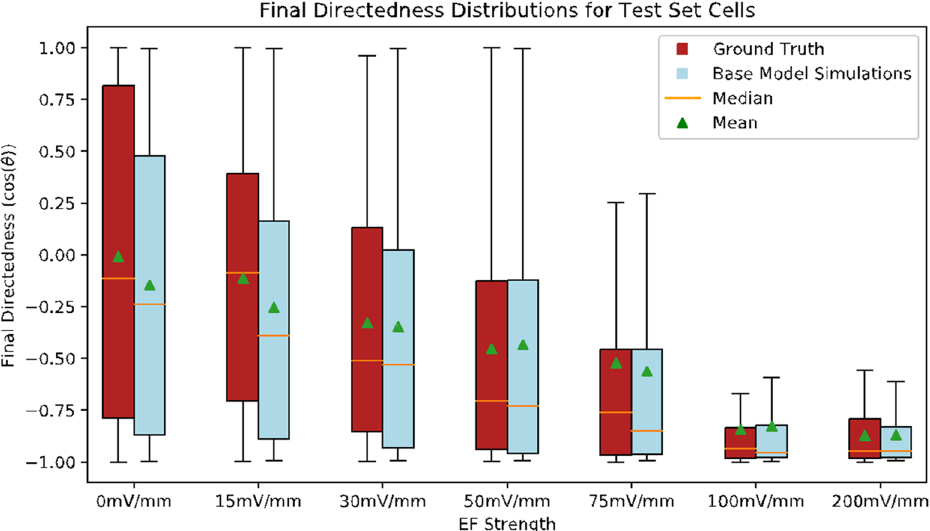
Figure 7. Distributions of final directedness values of cells in both ground truth data and synthetic data generated by simulations. The boxes represent the middle 50% of cell directedness values and the whiskers extend to the minimum and maximum directedness values for each distribution. For simulations, these distributions are over 50 trained models to ensure that these results are not dependent on the random initialization of any one model; see “Materials and methods” subsection “Recurrent model architecture” for more details. See Table S7 for mean and median values of final directedness values for both ground truth and synthetic